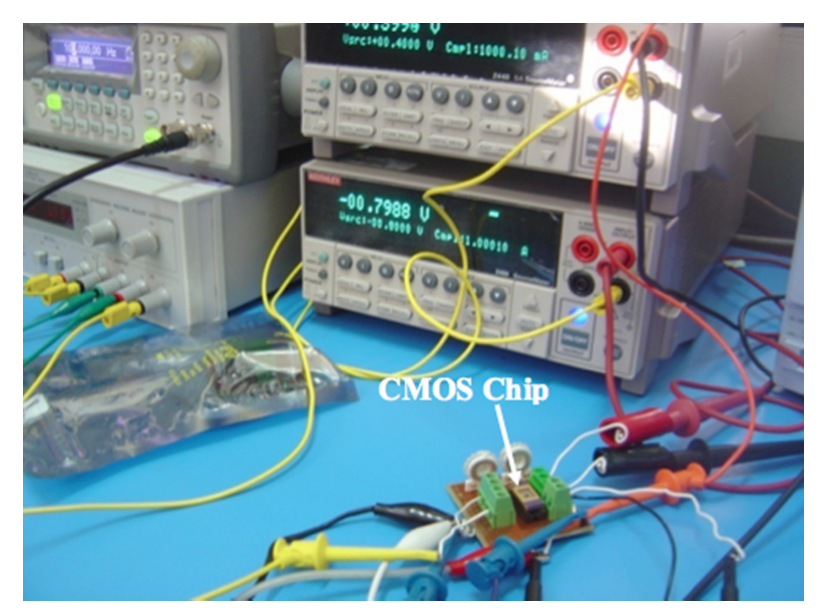
Figure 15. Frequency response of the readout electrical circuit of the CMOS